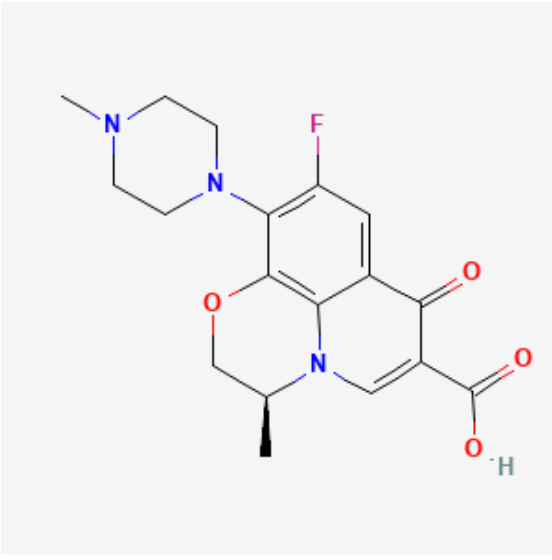
Figure 2. 2D chemical structure of